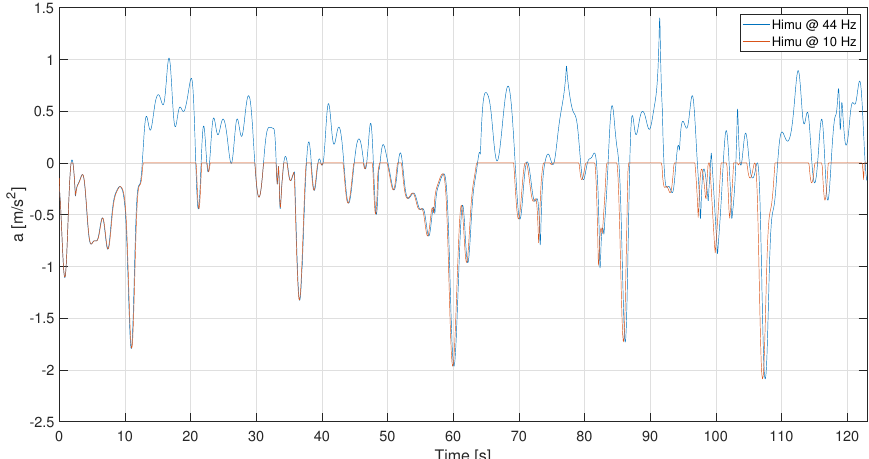
Figure 9. C1—HIMU acceleration signal resampled.